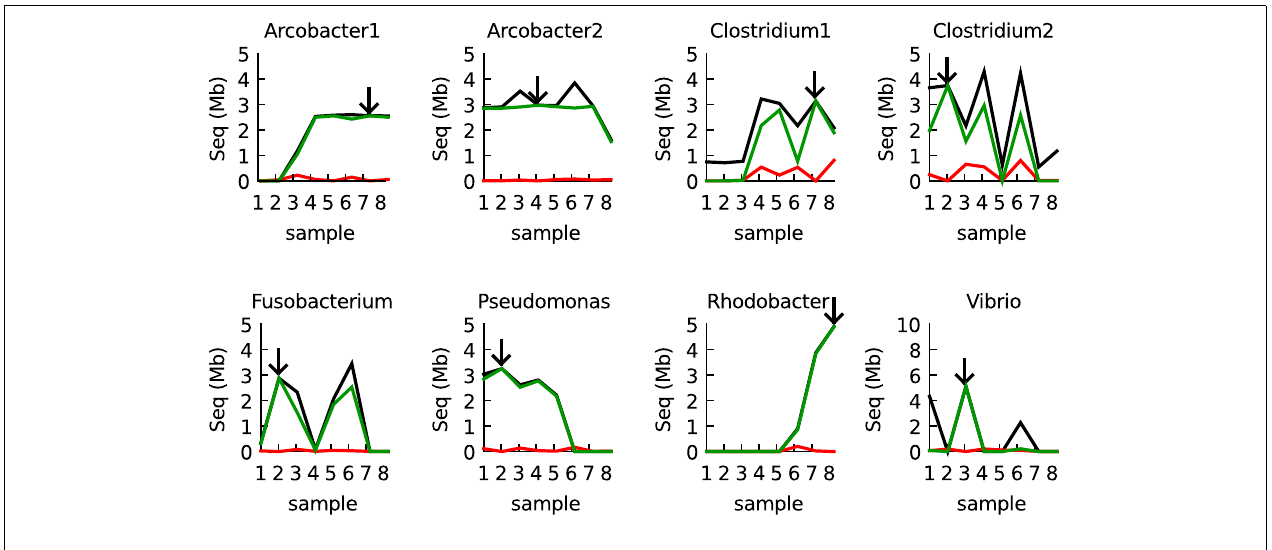
that data was also recovered by BLAST (megaBLAST at 98% identity cutoff).The red line shows how much data was recovered in other bins (errors). Arrows indicate the origin of the reference bin used to train the